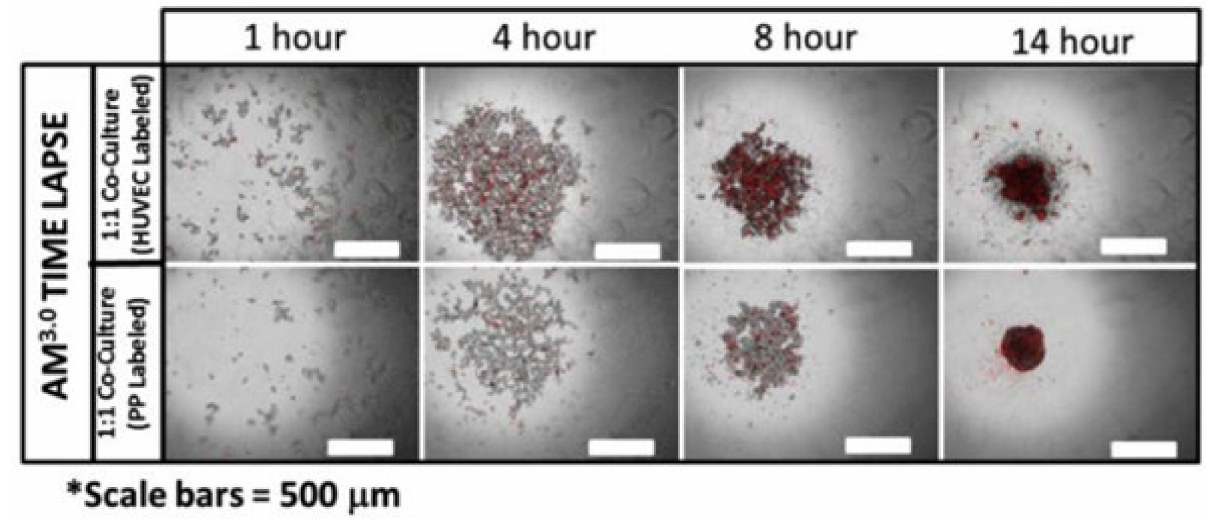
Figure 4. Generation of heterogeneous, multicellular islet organoids on Amikagel. Time-lapse imaging of co-culture aggregation on Amikagel (labeled cell population in red: HUVEC top row and hESC-PP bottom row). Reprinted with permission from [115]. Copyright (2018)